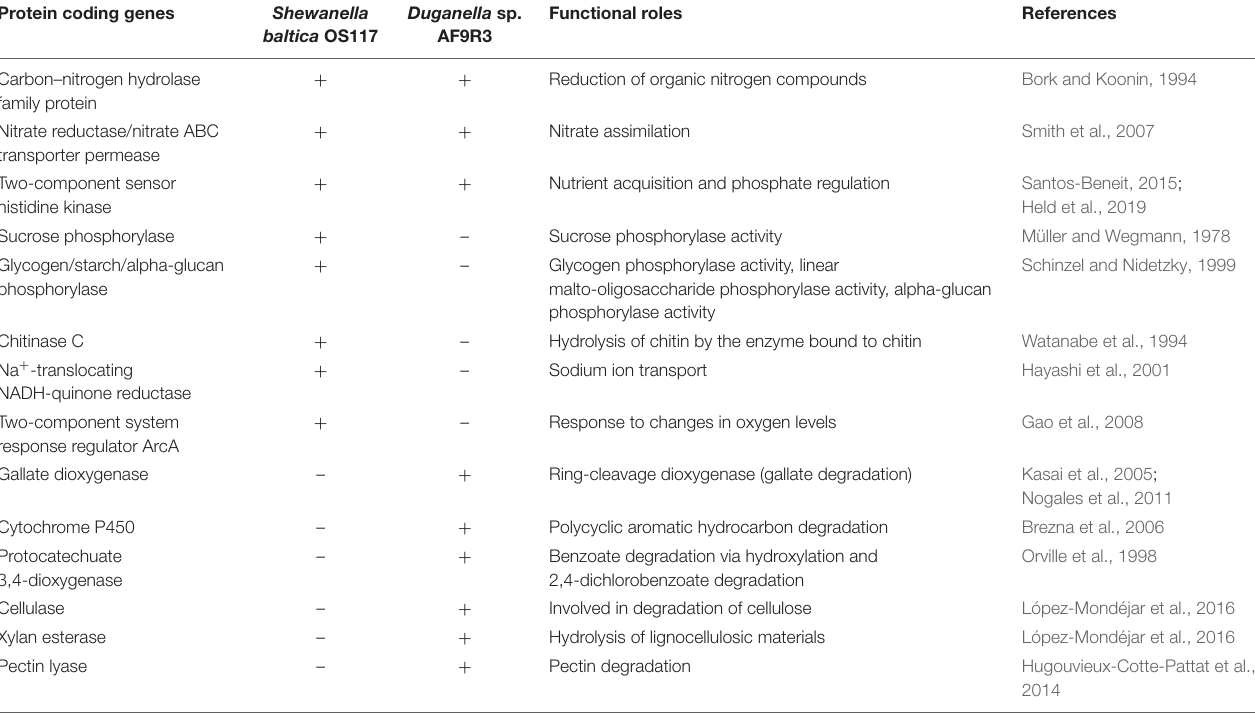
TABLE 3 | Comparative list of selected protein coding genes involved in carbon, nitrogen, and phosphorous metabolism in the closest genomes of Shewanella and Duganella species. Protein coding